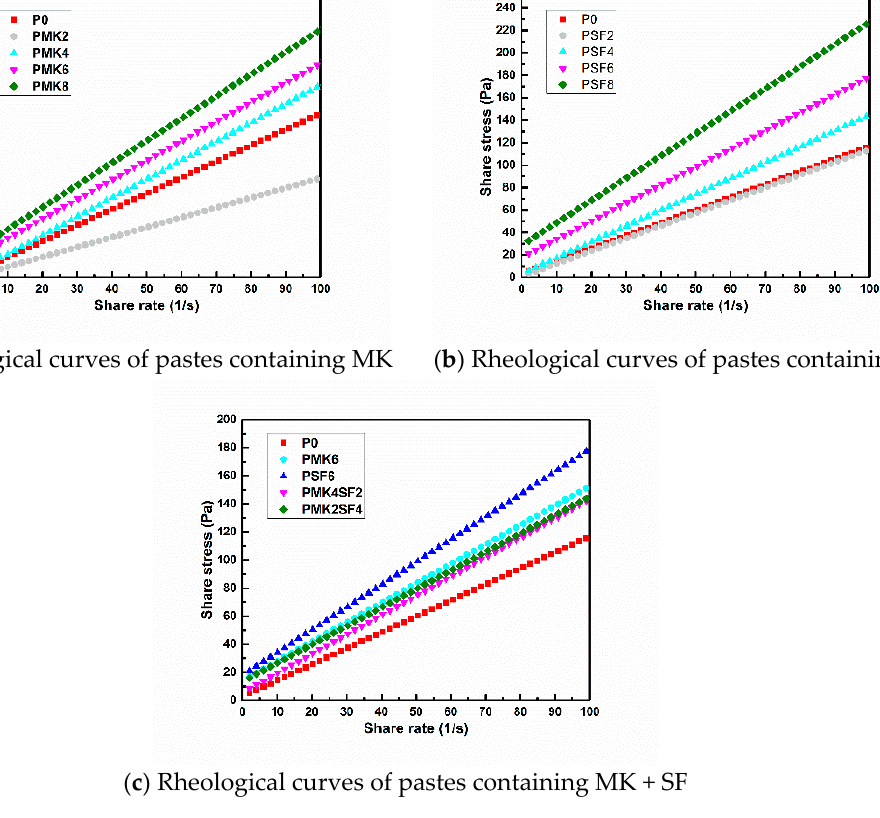
Figure 4. Rheological curves of pastes containing metakaolin (MK) and silica fume (SF).